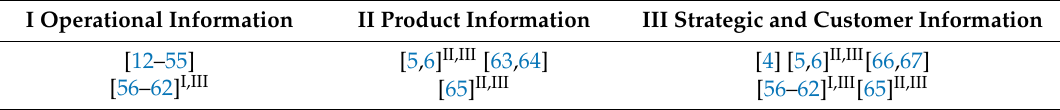
Table 4. Overview of the types of informational